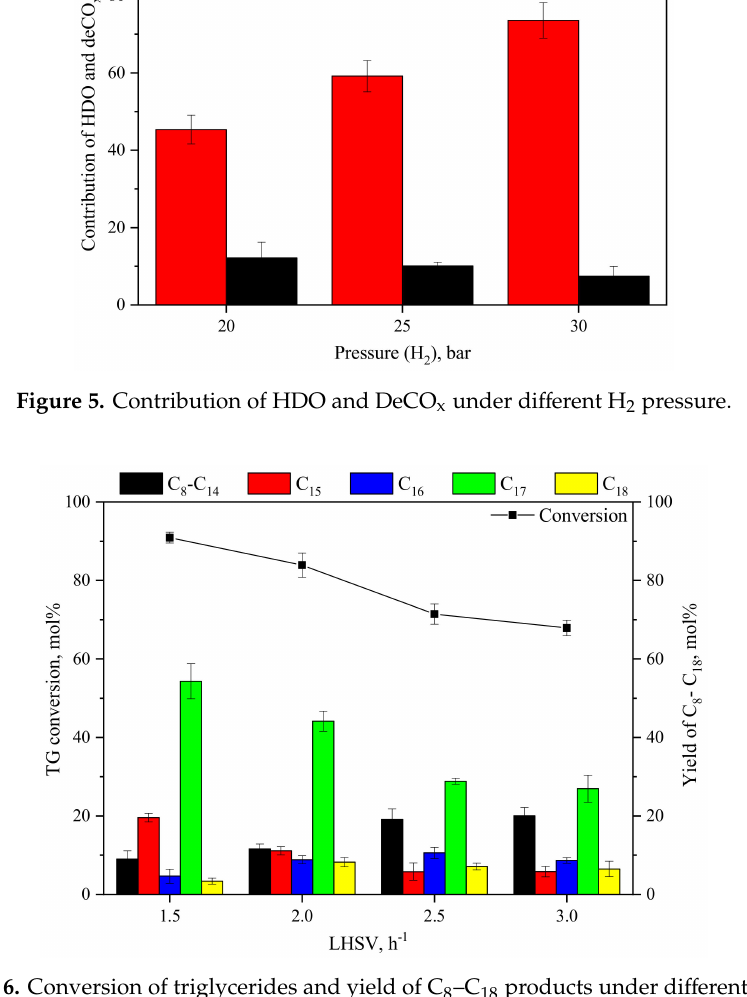
Figure 6. Conversion of triglycerides and yield of C 8 –C 18 products under di ff erent